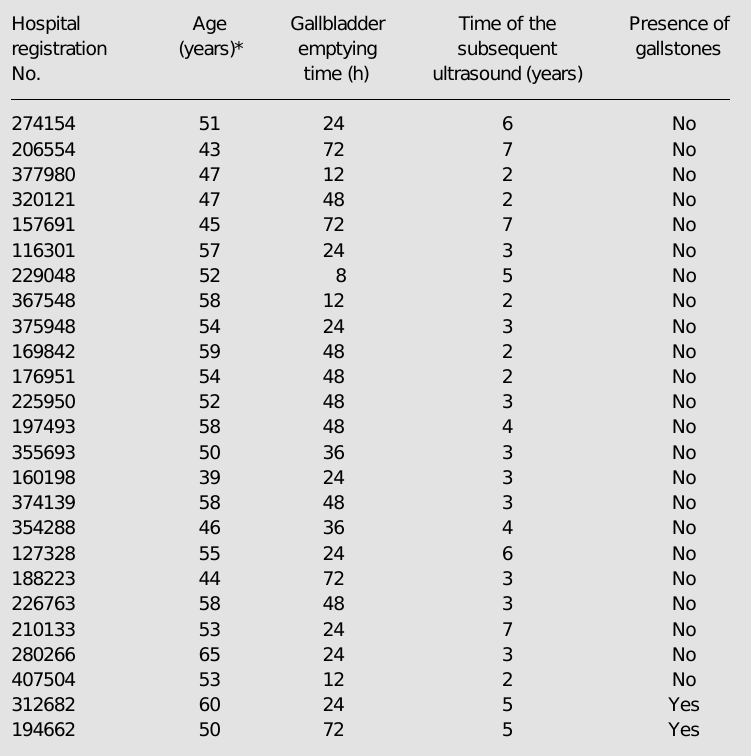
Table 1 - Gallbladder emptying time in 25 women in the perimenopausal period, and presence of gallstones at ultrasound during follow-up. *Patient age was that at the time of the first